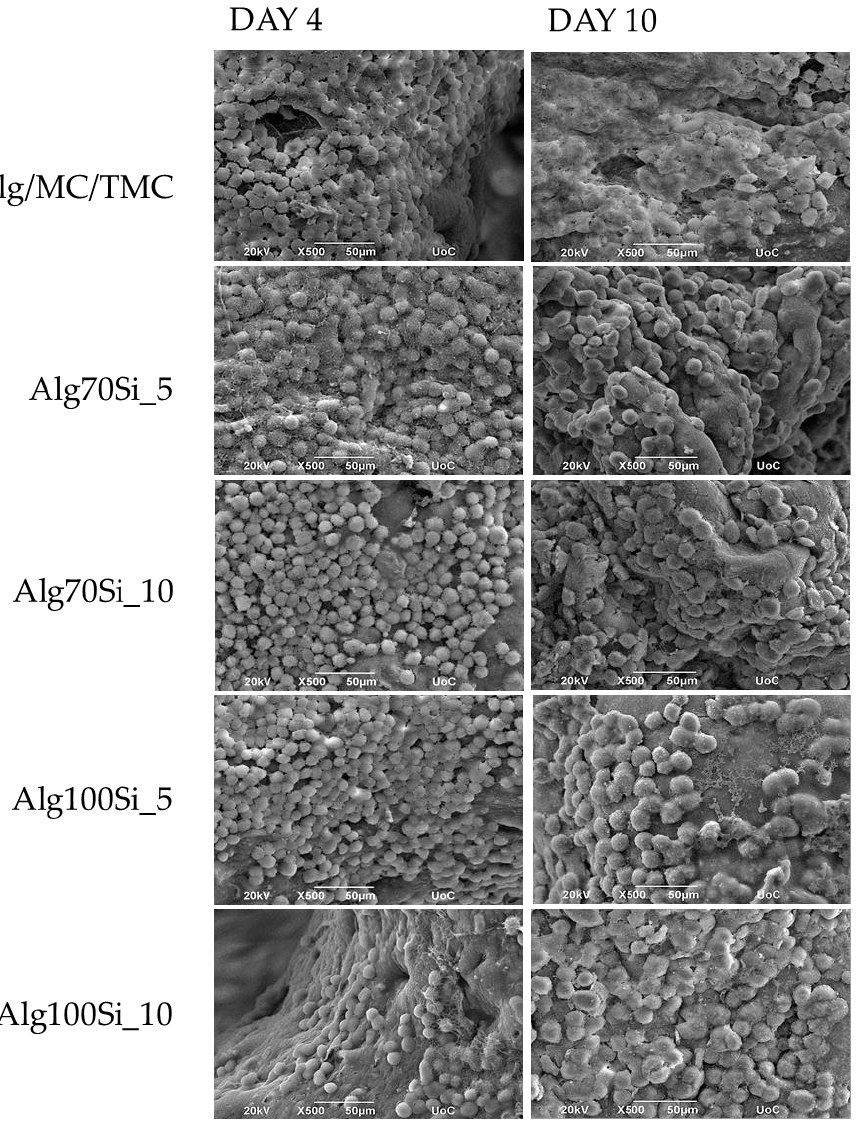
Figure 8. Scanning electron micrographs illustrating MC3T3-E1 cell adhesion and growth on Alg/MC/TMC, Alg70Si_5, Alg70Si_10, Alg100Si_5, and Alg100Si_10 during 4 and 10 days of cell culture. Original magnifications are ×500.